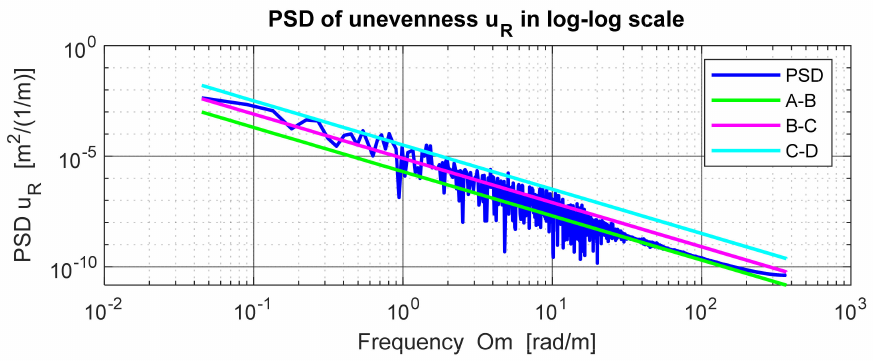
Figure 5. PSD of right road profile in log-log